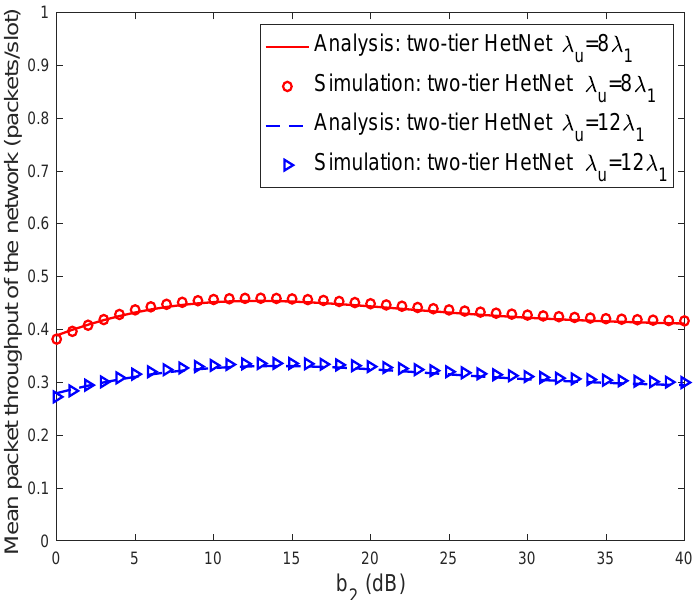
Figure 2. The mean packet throughputs of the network versus b 2 . b 1 = 1 .